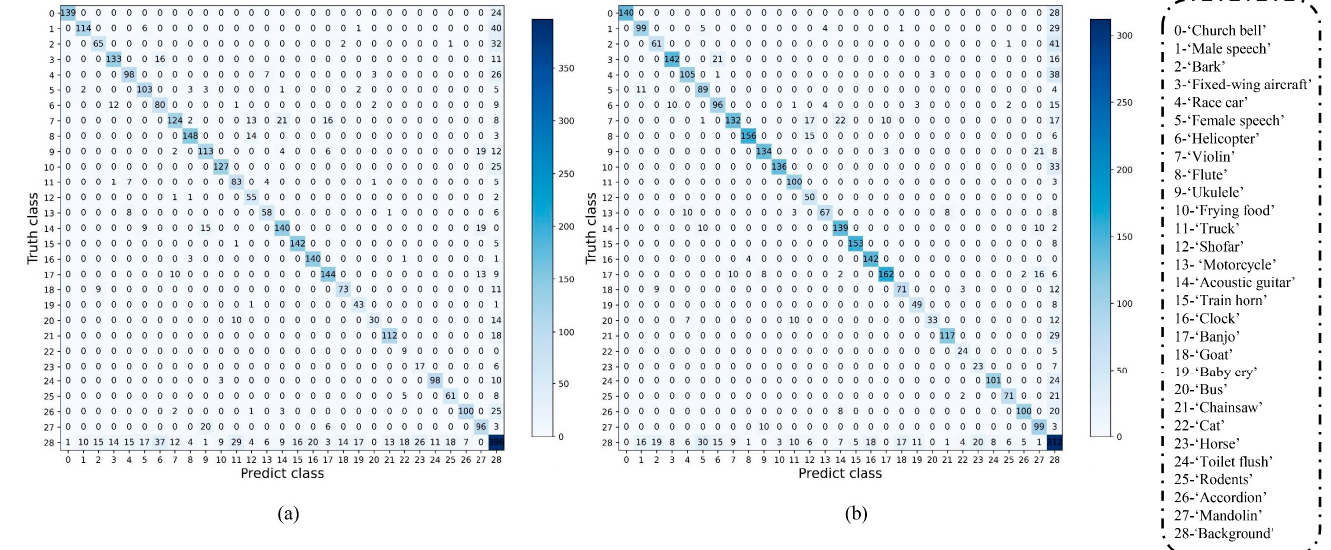
Figure 5. The confusion matrices of the classification results based on the representations of AV‑BT and the whole proposed method are shown in ( a ) and ( b ), respectively. The classes corresponding to the numbers in the axes of the confusion matrix are shown in the dashed boxes on the right.